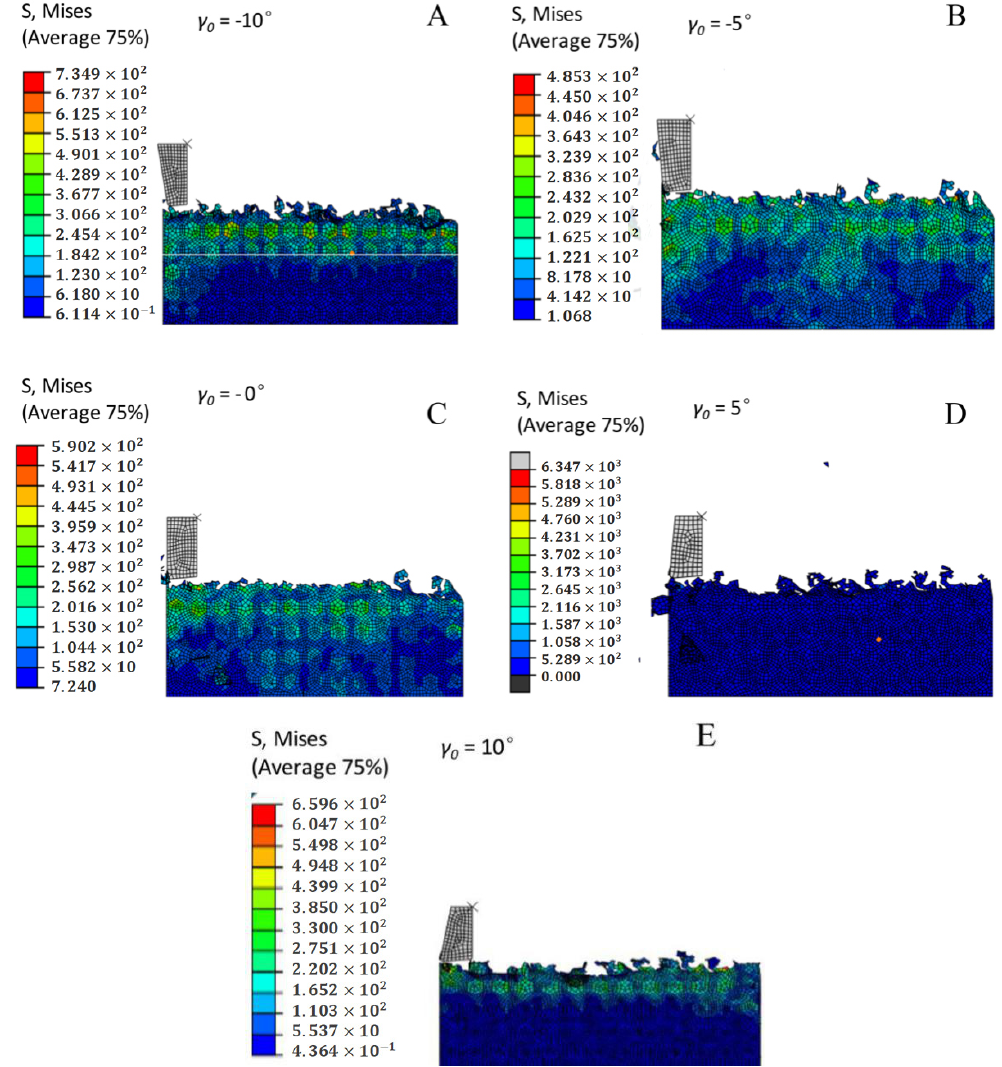
Figure 14. Chip morphology in milling with different tool rake angles. ( A ) γ 0 = − 10°. ( B ) γ 0 = − 5°. ( C ) γ 0 = 0°. ( D ) γ 0 = 5°. ( E ) γ 0 = 10°.